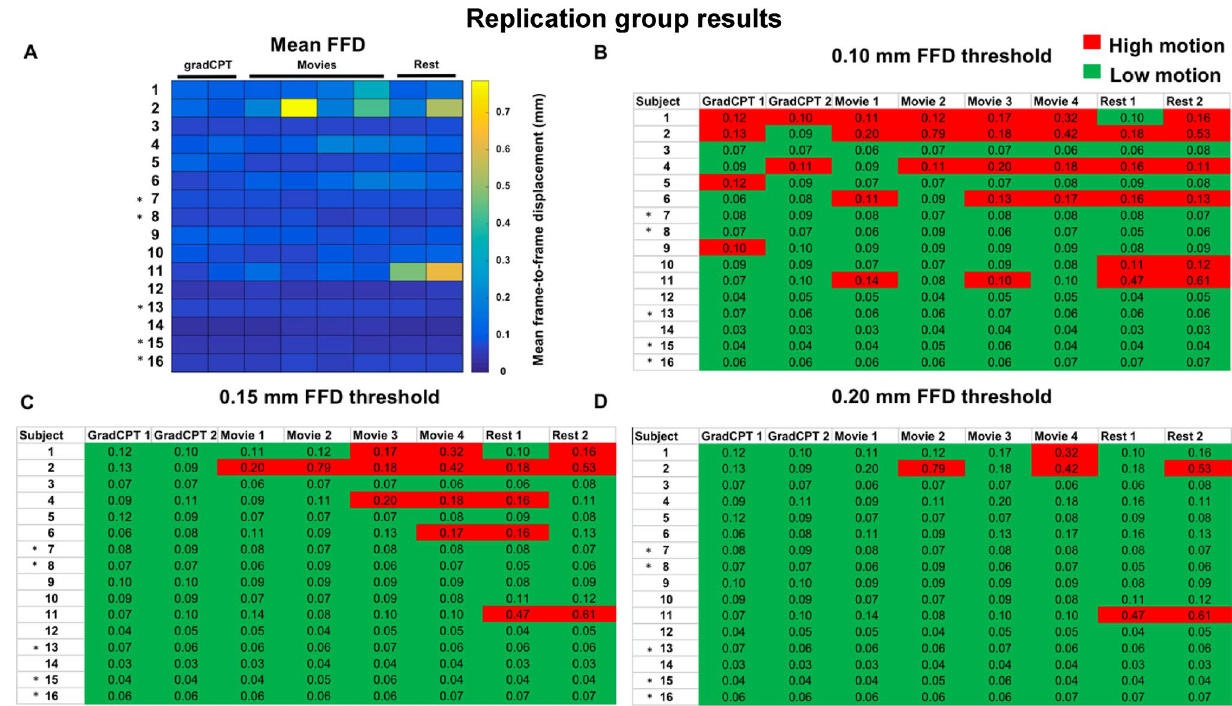
Figure 3. Low-motion data can be obtained in a replication group of participants. Participants with ASD are denoted by an asterisk (‘*’) to the left of subject number in each plot. For all plots ( a – d ), each row represents a different participant; each column indicates a different scan condition (scan labels are shown at the top of each plot). Note that the data are presented in functional run order: the gradCPT scans are the first functional scans conducted; the rest scans are the last functional runs conducted. ( a ) A matrix of the mean FFD values for each participant. ( b – d ) The same data from ( a ) are plotted, except scans are classified as being either a “high-motion” scan (i.e. the scan had a mean FFD above the relevant threshold) or a “low-motion” scan (the scan had a mean FFD below the threshold). The mean FFD value for each scan is shown in each cell. Note that for visualization, we have rounded the mean FFD value to two significant figures; when we classified a scan as low or high- motion, we used four significant figures ( FFD frame-to-frame displacement; mm millimeters).